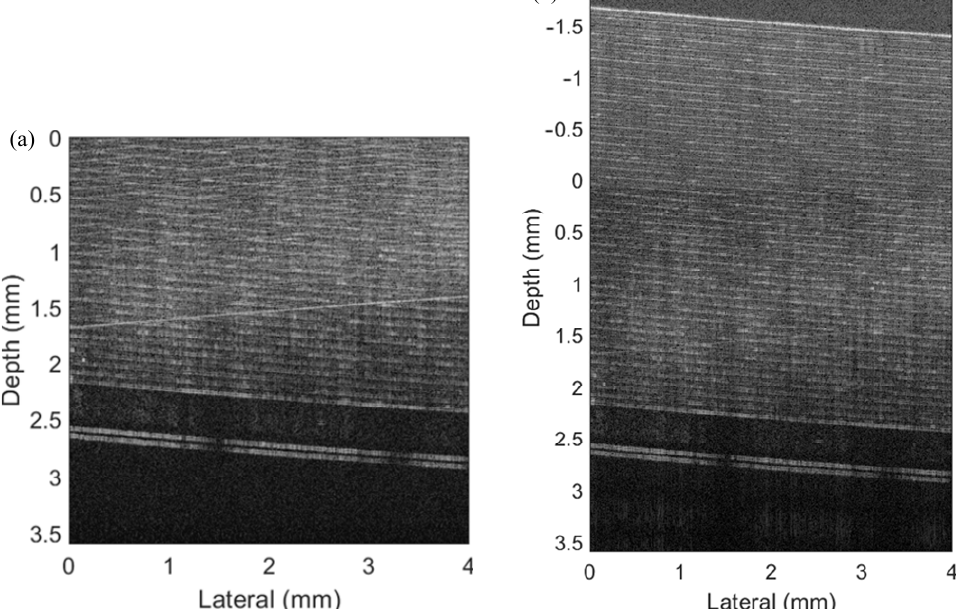
Figure 5. The experimental results of Scotch tape. ( a ) The conventional OCT image with conjugate artifacts, which are overlapped with the real image. ( b ) The FROCT image reconstructed by our proposed method using a voice coil motor. The FROCT image presents a larger imaging depth without mirror artifacts even though the zero-phase delay is inside the sample.